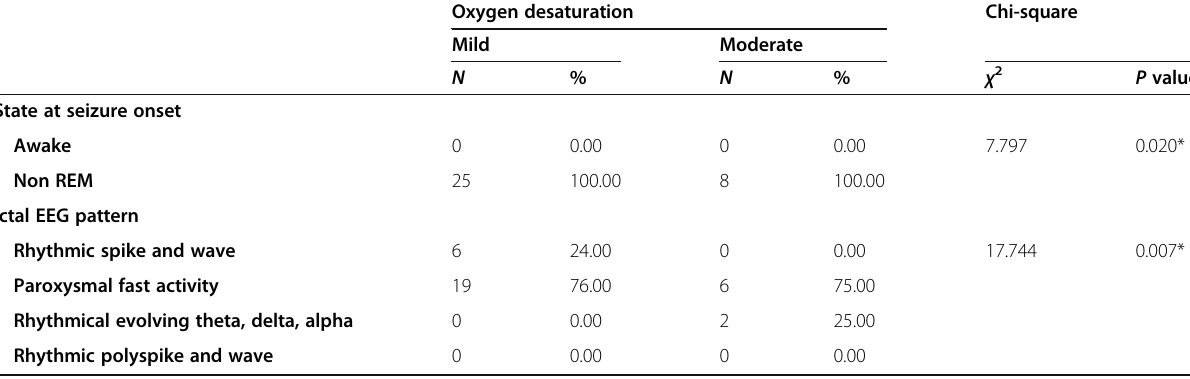
Table 4 Correlations between oxygen desaturation and ictal EEG pattern and state at seizure onset Oxygen